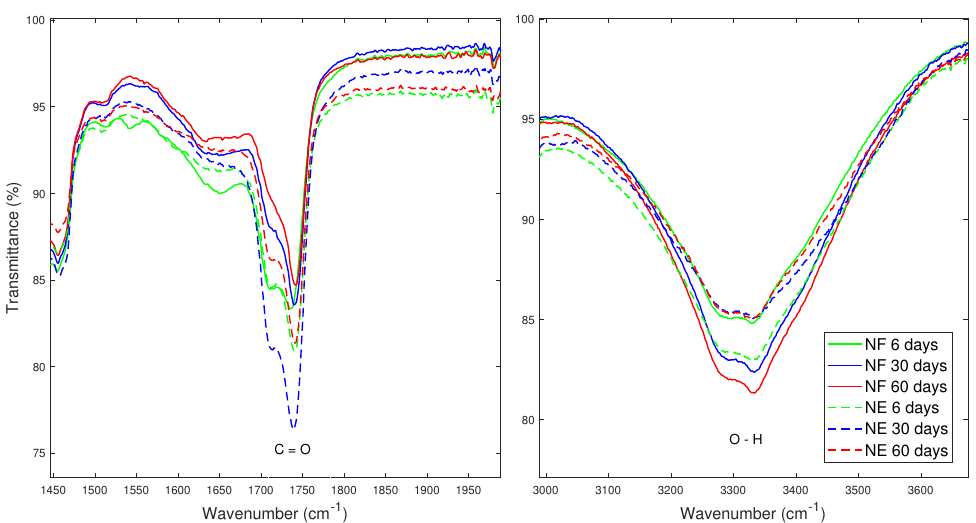
Figure 12. Details of FTIR spectrum of cellulose impregnated with NF and NE, subjected to different aging